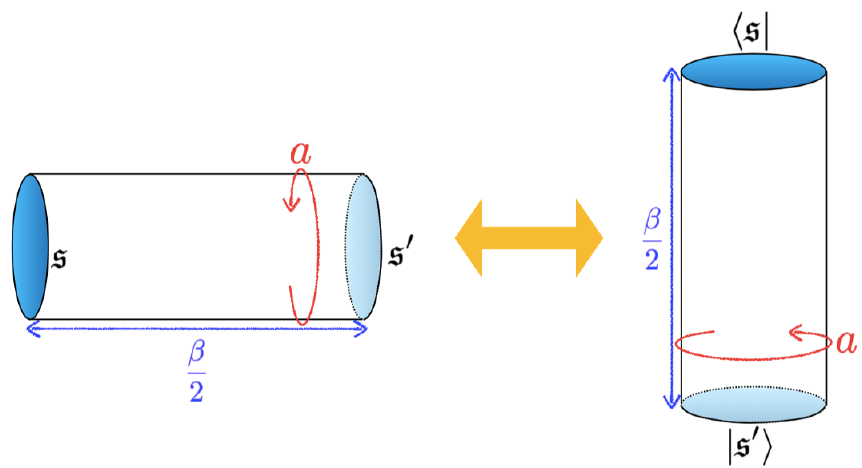
Figure 3. An open string Partition function with generic boundary conditions is the same as a closed string amplitude between corresponding boundary